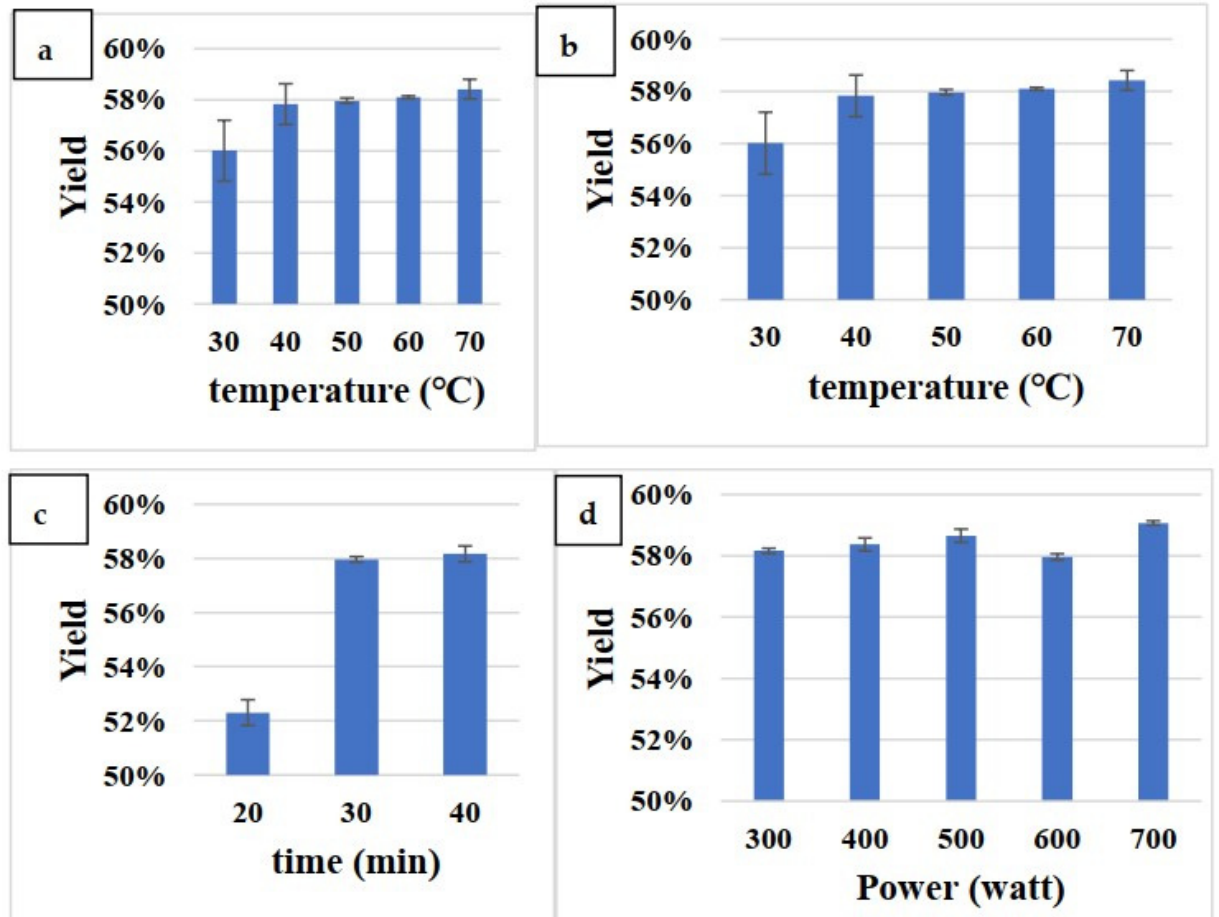
Figure 1. The extract yield of various parameters of MAE: solid/solvent ratio ( a ), operating temperature ( b ), extraction time ( c ), and microwave power ( d ). Values are expressed as mean ± SD (n = 3).